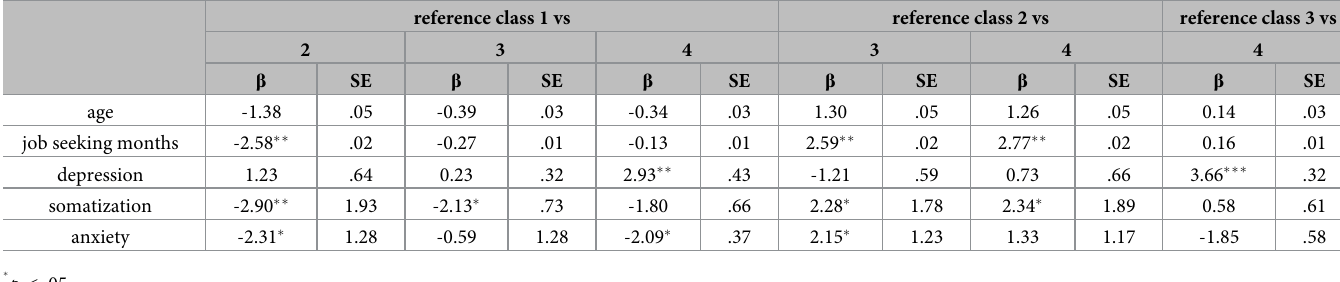
Table 3. Associations between psychosocial predictors and class